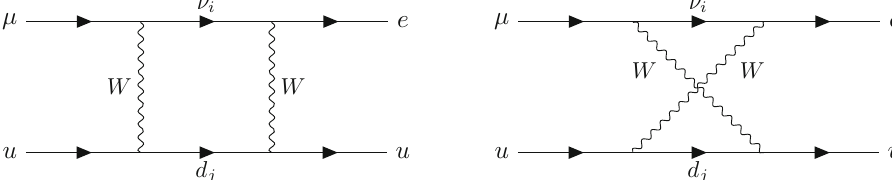
Fig. 2 Example of box diagrams (depicted for the box contributions to neutrinoless μ − e conversion). In the quark internal lines, j = 1 ,..., 3 runs over the quark families; in the neutral fermion ones, i = 1 ,..., 3 + n